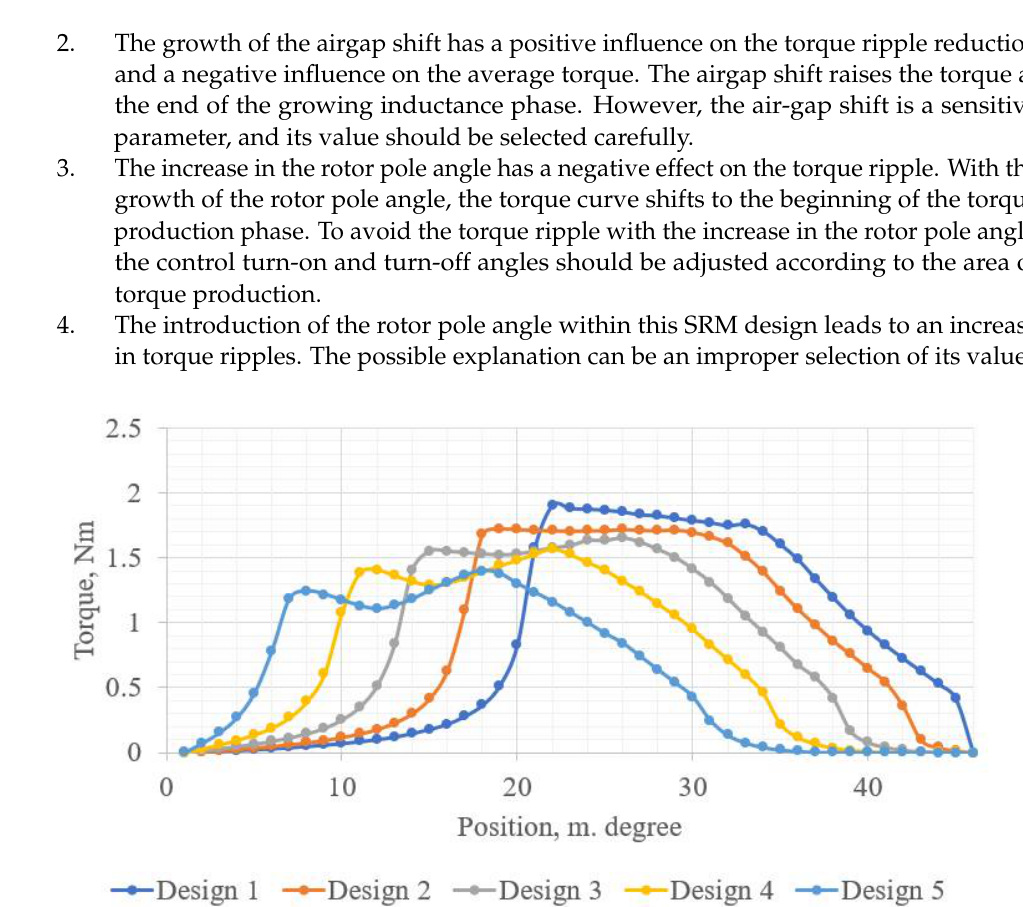
Figure 17. Static torque curve for Taguchi designs with different levels of air-gap shift and rotor pole angle.